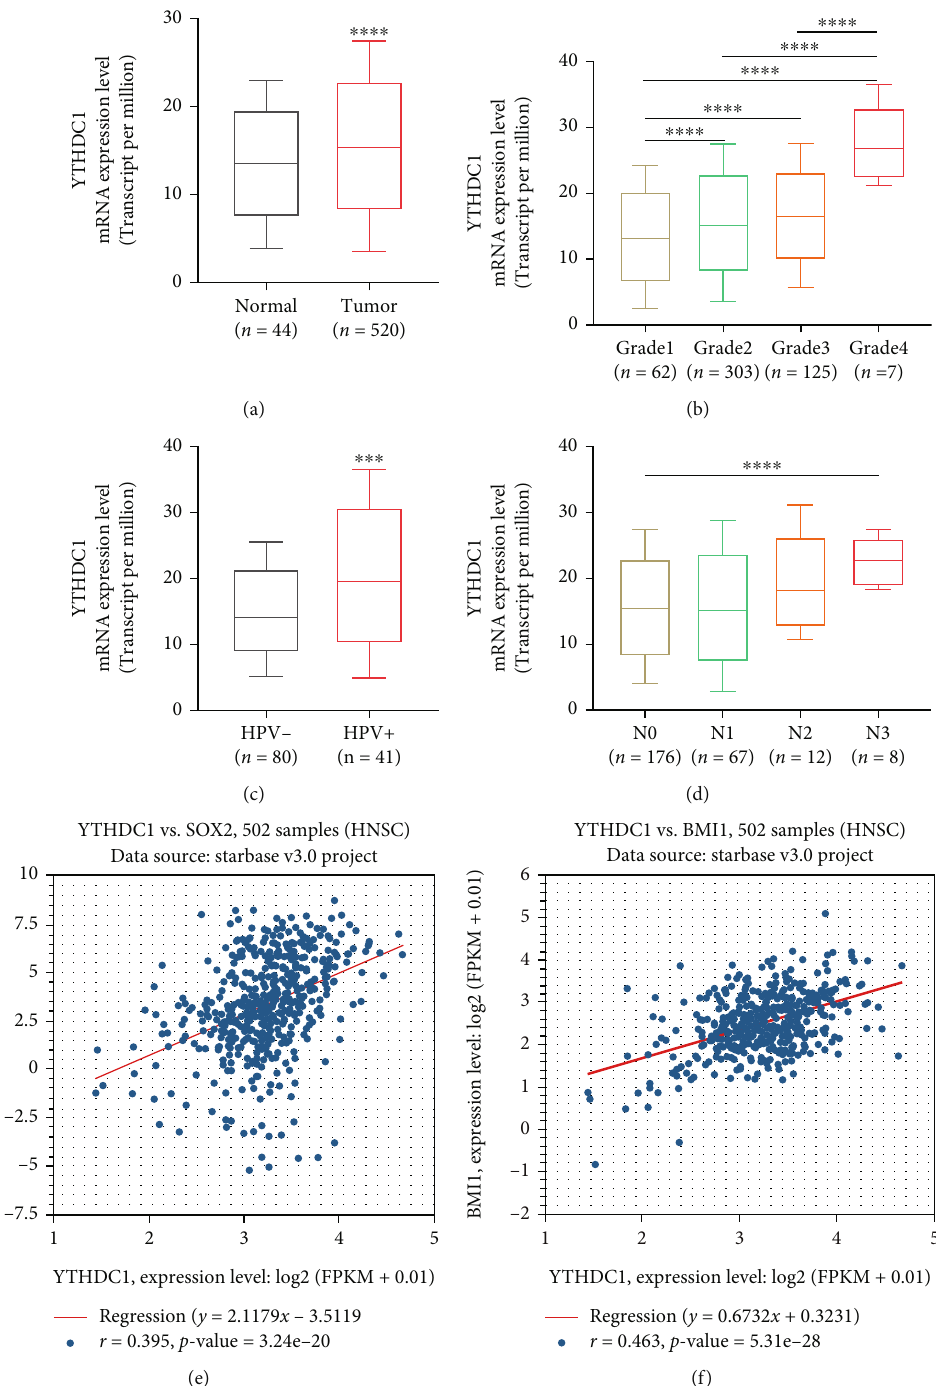
Figure 2: YTHDC1 aberrantly expressed in HNSCC and was associated with cancer cell stemness. (a) The relative mRNA expression of YTHDC1 in tumor and normal tissues in HNSCC in TCGA database. The comparison of the YTHDC1 mRNA expression in (b) individual tumor grades, (c) HPV infection status, and (d) di ff erent nodal metastasis status. (e) The Pearson correlation between YTHDC1 and SOX2 mRNA expression in HNSCC according to TCGA data. (f) The Pearson correlation between YTHDC1 and BMI1 mRNA expression in HNSCC according to the TCGA